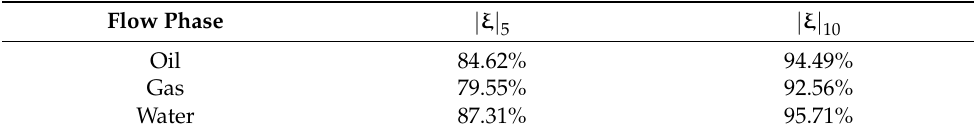
Table 7. | ξ | on the testing-1 dataset for different flow phases using the CNN-based prediction e